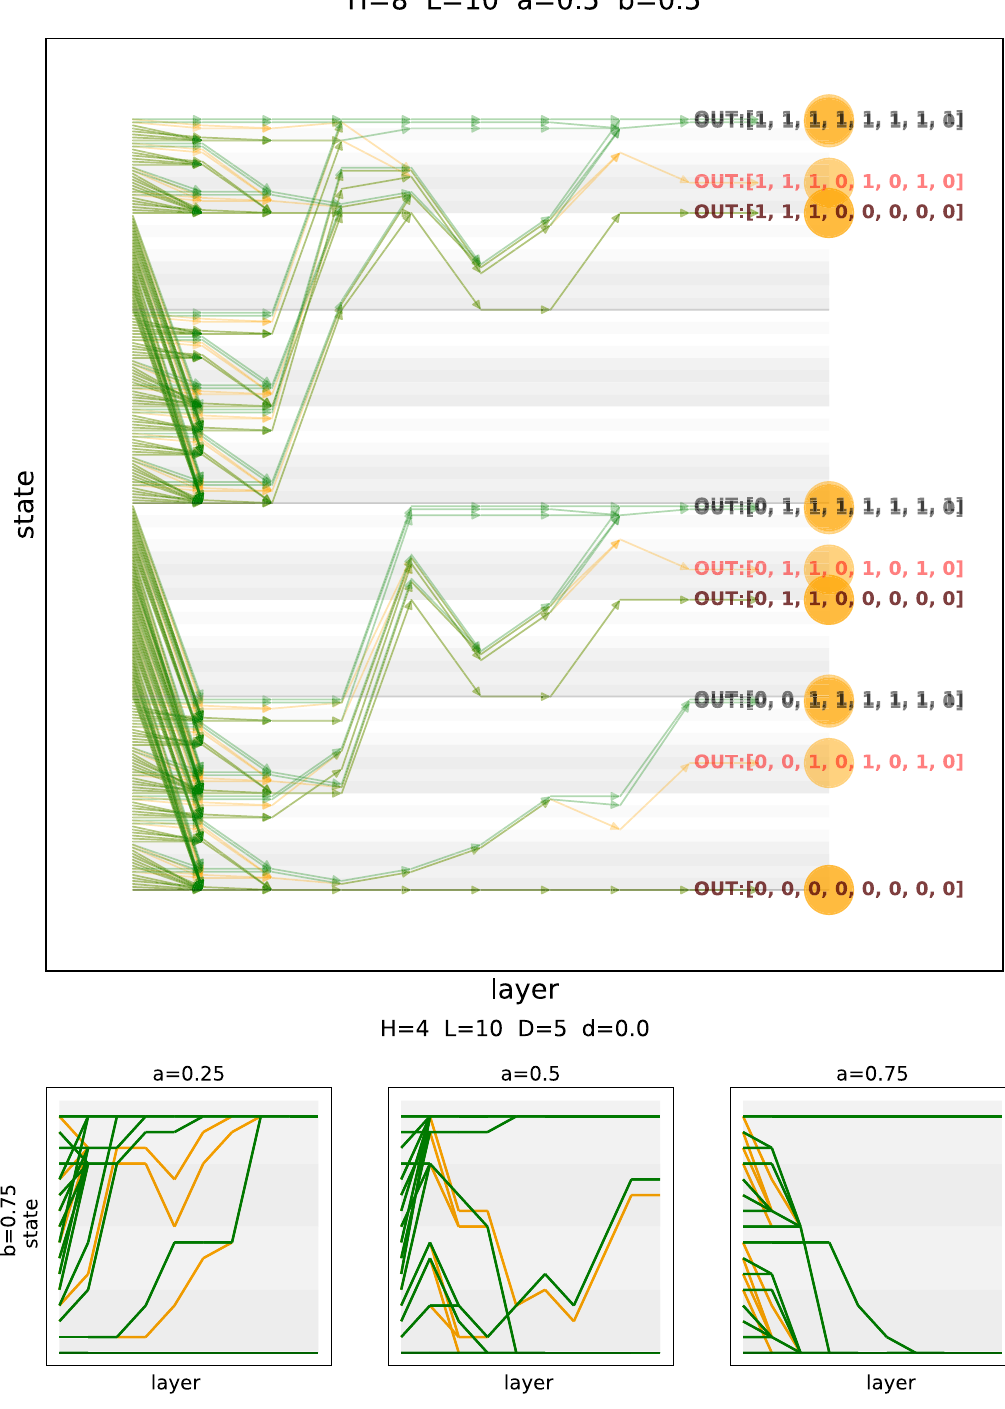
Figure 6. (Top) Detailed view of the state space evolution. Input states (left; sorted according to the binary number they represent) are converted into output states (phenotypes; right) by the network. The number of phenotypes is usually much smaller than the number of possible input states. Green indicates a trajectory in the healthy network, while orange indicates a trajectory in the disease network. (Bottom) Stylized views of the state space evolution for different values of a